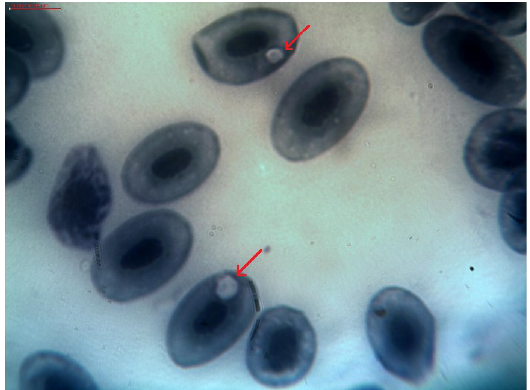
Fig. 2. Two intraerythrocytic Rickettsia of the Natrix natrix